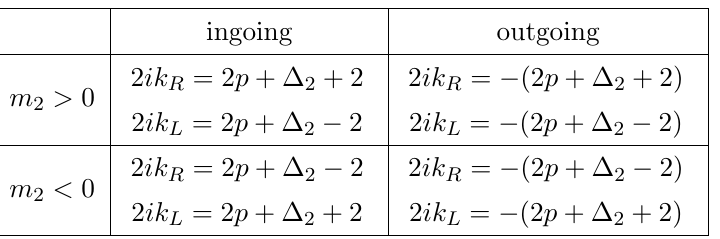
Table 1 . Spin-2 quasinormal mode spectrum ! ? after imposing standard Dirichlet boundary con- ditions. When (cid:1) 2 = 2 these correspond to the symmetric, transverse, traceless graviton spectrum. Each condition on k R or k L labels a distinct eigenmode and the range of p is over all non-negative integers.